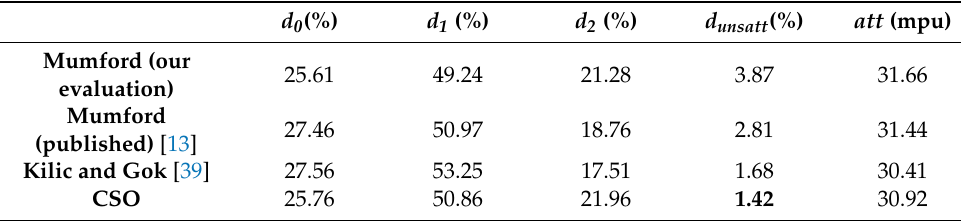
Table 16. Comparative results for the best solutions for Mumford3